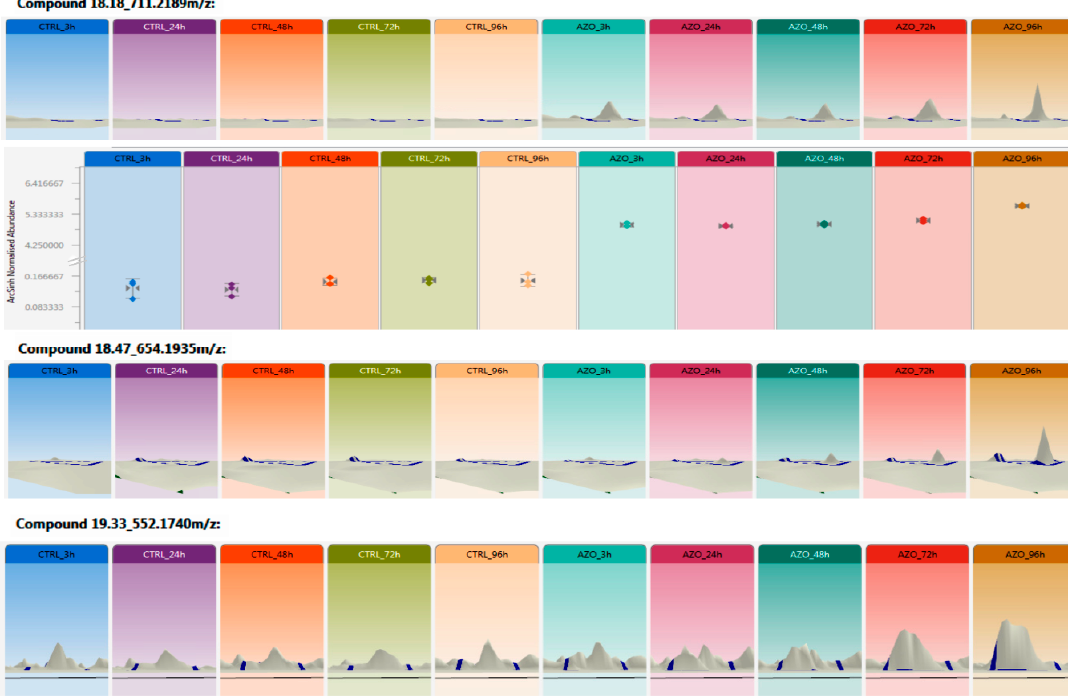
Figure 6. Relative Ion abundance distribution of azoxystrobin-GSH (glutathione) conjugate at MS survey conditions as quantified by the Progenesis QI software for metabolomics. The label free relative spectral counting quantification analysis (here depicted as 3D isotope abundance) has revealed the di ff erential presence of the m / z 711.2189, accumulating over time (max at 96 h) in azoxystrobin treated roots versus the untreated control. The same trend has been detected for the peaks 654.1935 m / z and 552.1740 m / z .